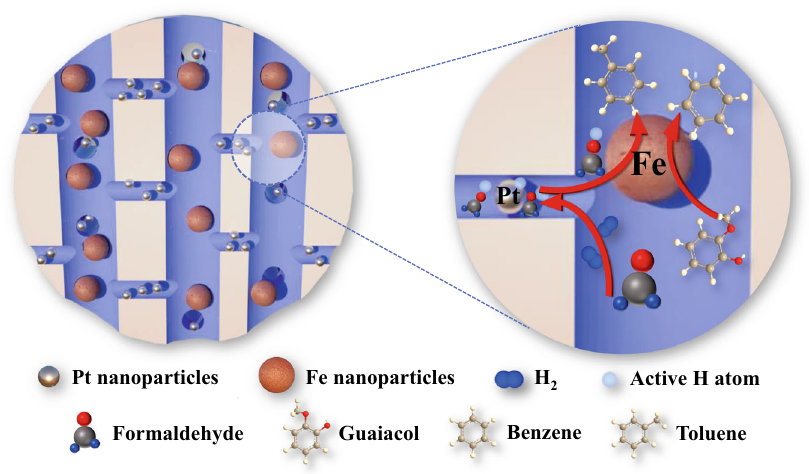
Fig. 1 Hydrogen spillover enhanced by oxygenate additives during catalysis. An oxygenate molecule (e.g., formaldehyde) acts as a H-carrier to promote hydrogen spillover for guaiacol hydrodeoxygenation on a hierarchically porous Pt@-Fe@SiO 2 catalyst.